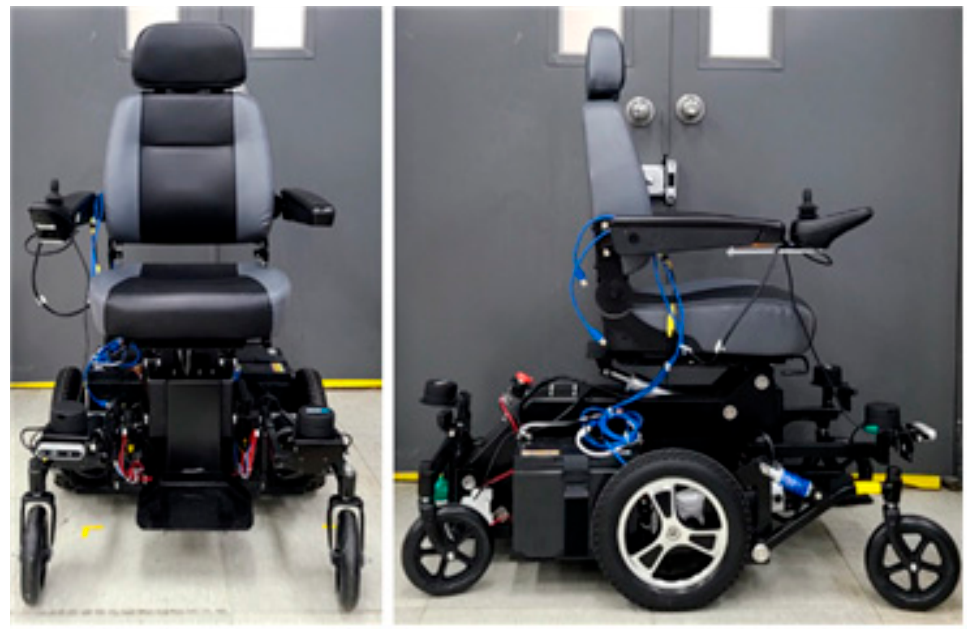
Figure 11. Appearance of the implemented